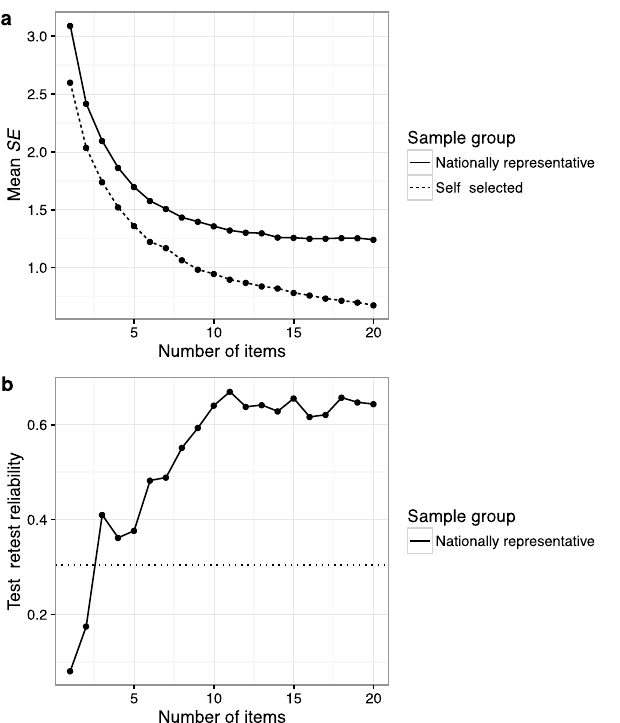
Figure 5. Reliability as a function of test length and sample group (test Version 1), as assessed by ( a ) mean SE of ability estimates and ( b ) test-retest reliability (Pearson correlation). The dotted line in ( b ) indicates the threshold of statistical significance at p < 0.05